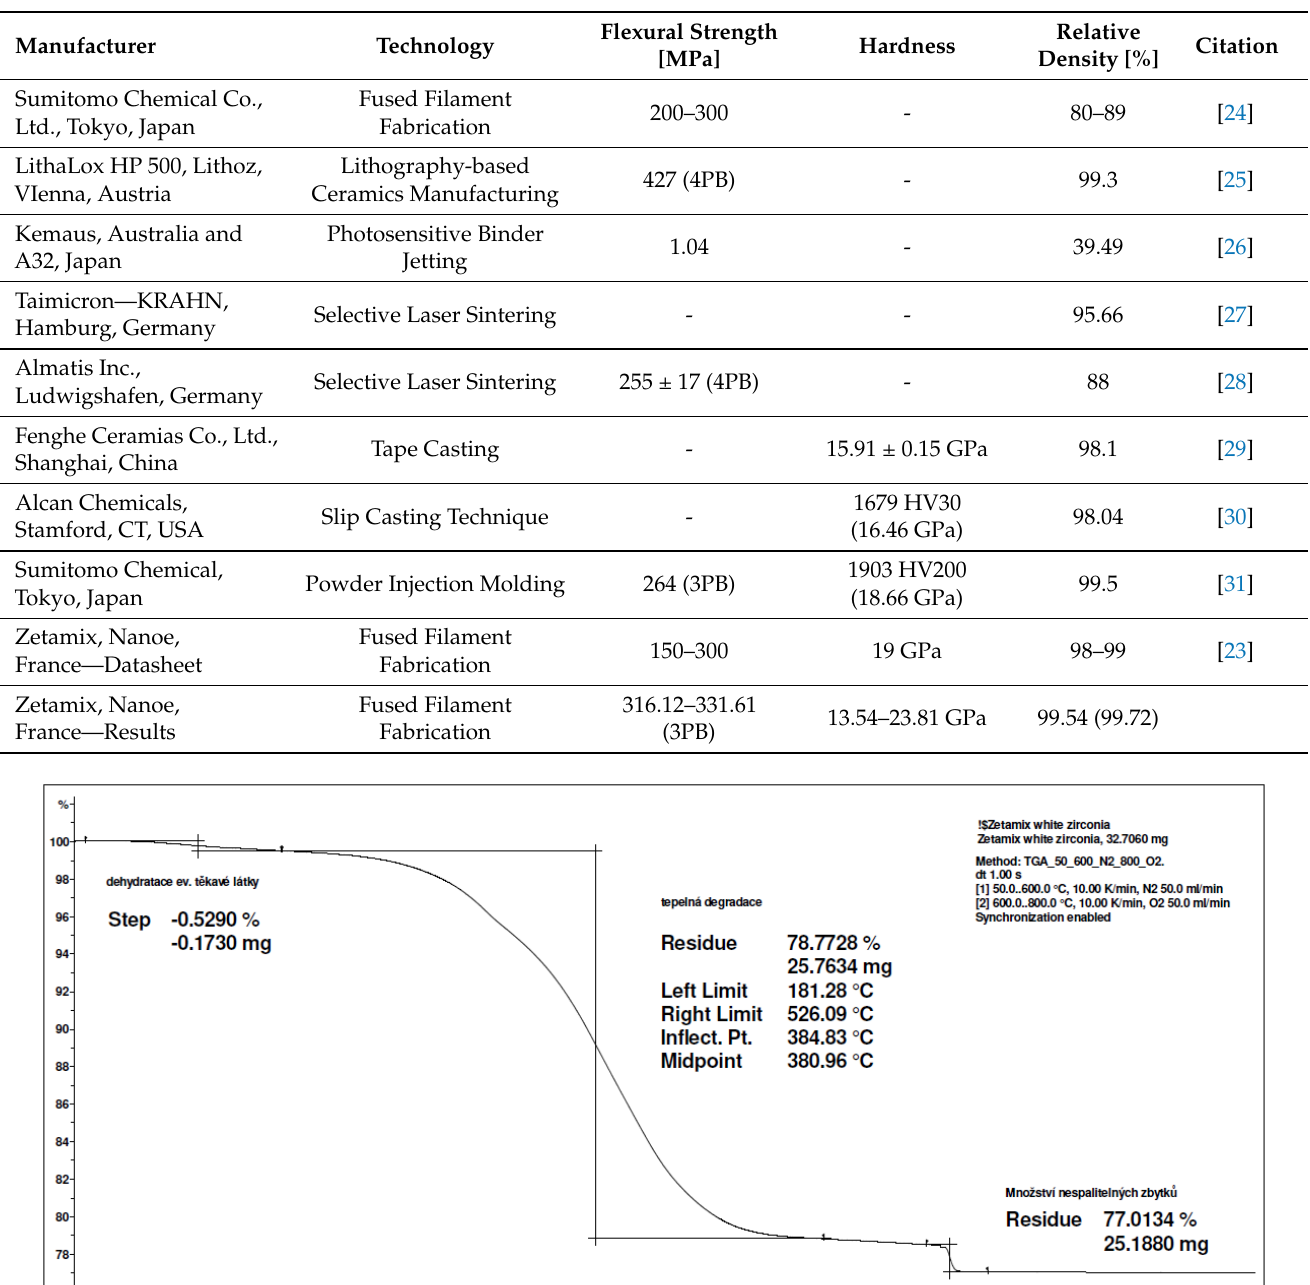
Table 1. Alumina material fabricated by AM and conventional technologies. Comaprison of porosity and mechanical properties reached in this study with results of other research teams.